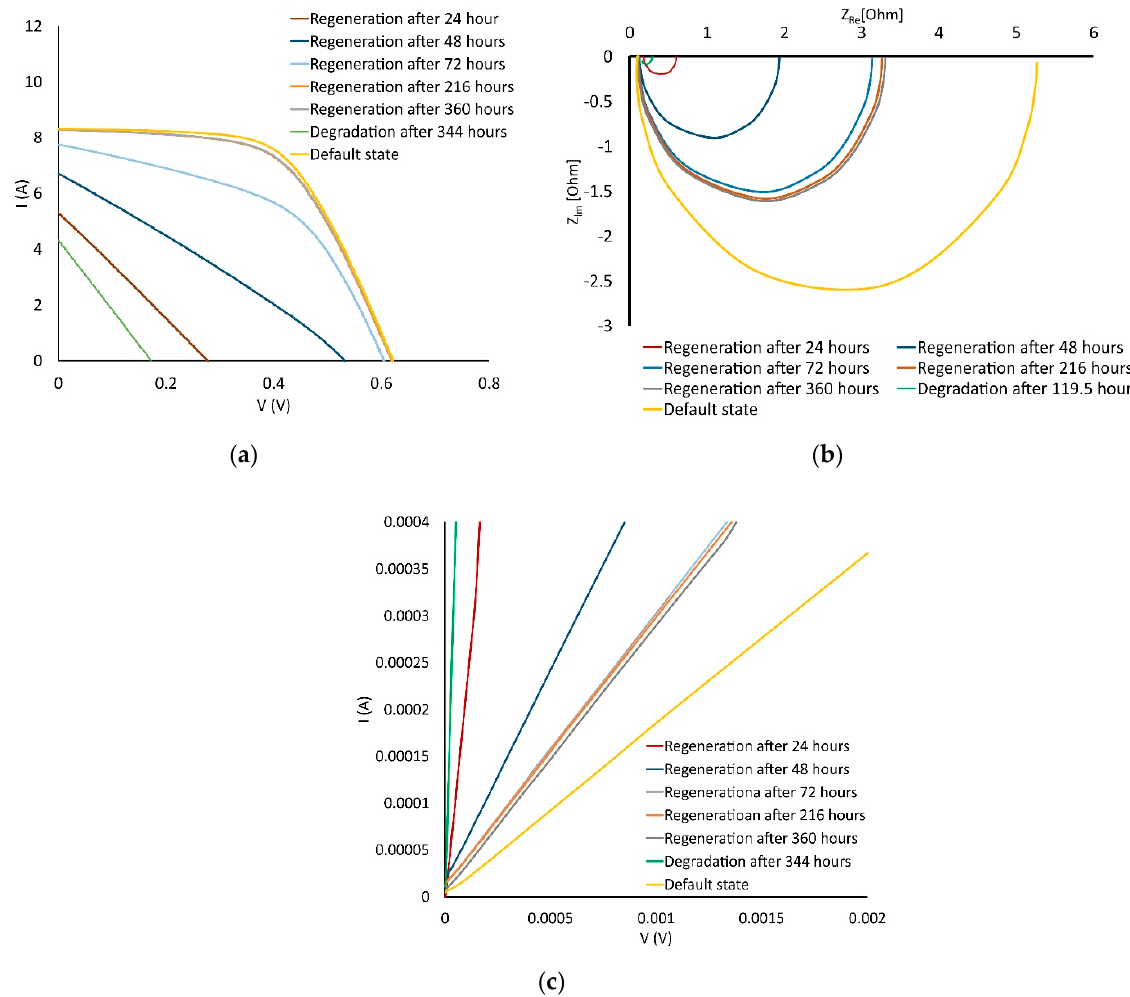
Figure 10. ( a ) I-V curves during regeneration for PV cell. ( b ) Cole-Cole curve during regeneration for PV cell. ( c ) Dark I-V curve during regeneration for PV cell.